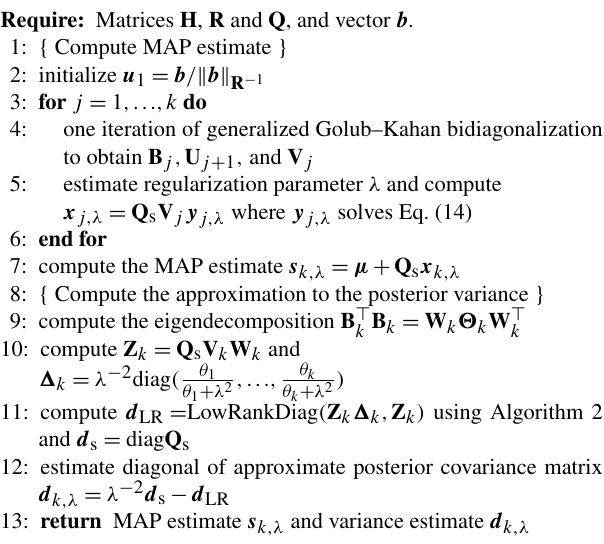
Algorithm 1 AIM with fixed mean – genHyBRs with UQ.